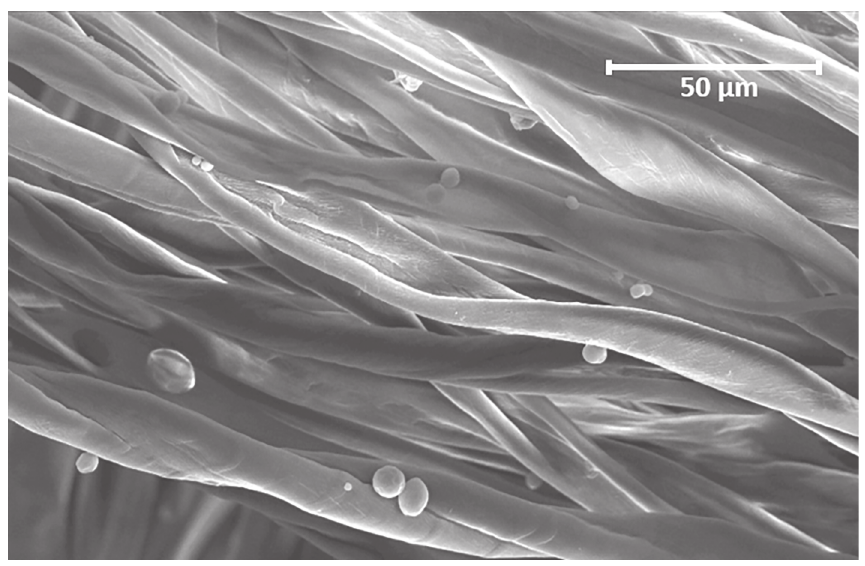
Fig 6. Scanning electron microscope (SEM) image of a cotton net fabric containing